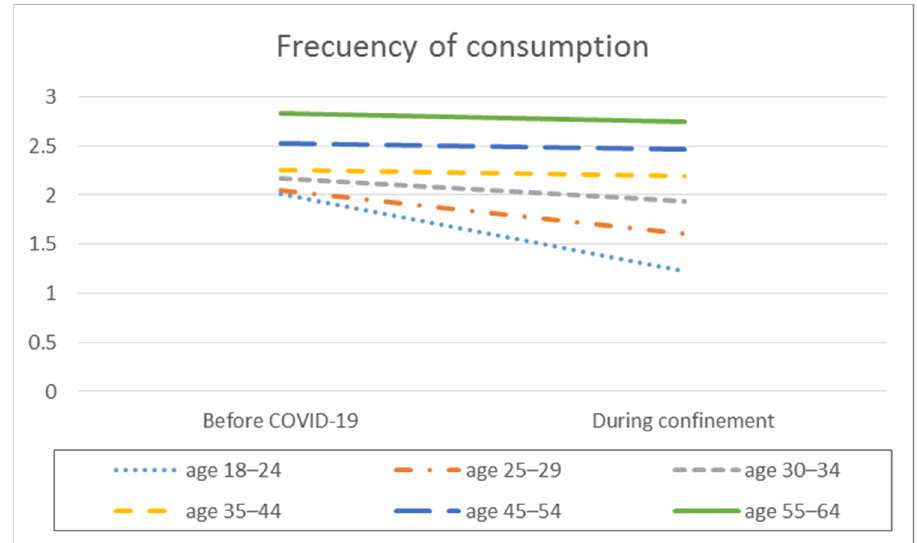
Figure 1. Average frequency of consumption by age before the pandemic and during COVID-19 confinement.